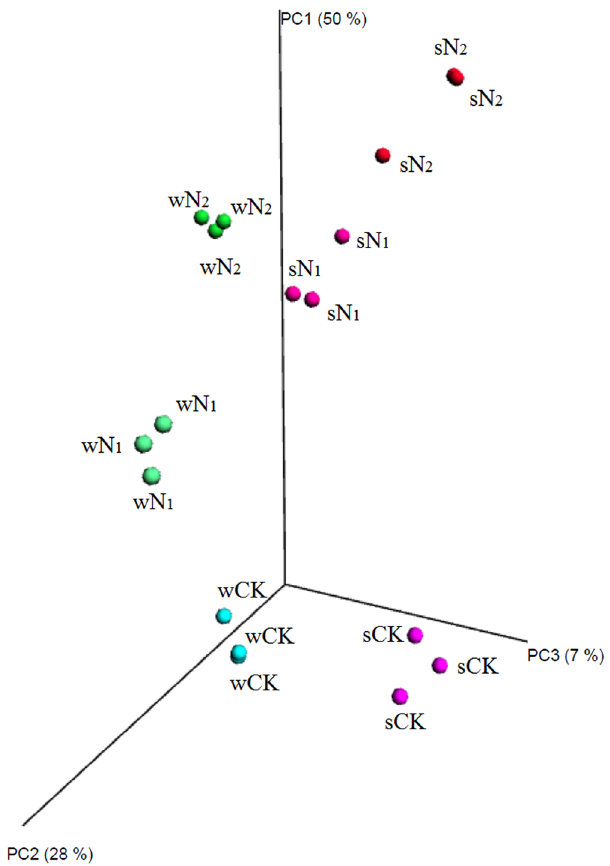
Figure 5. Principal coordinate analysis of pyrosequencing reads obtained from soils subjected to different fertilization regimes based on the weighted Fast UniFrac metric. The first three axes are shown and the percent of variance explained by each axis is